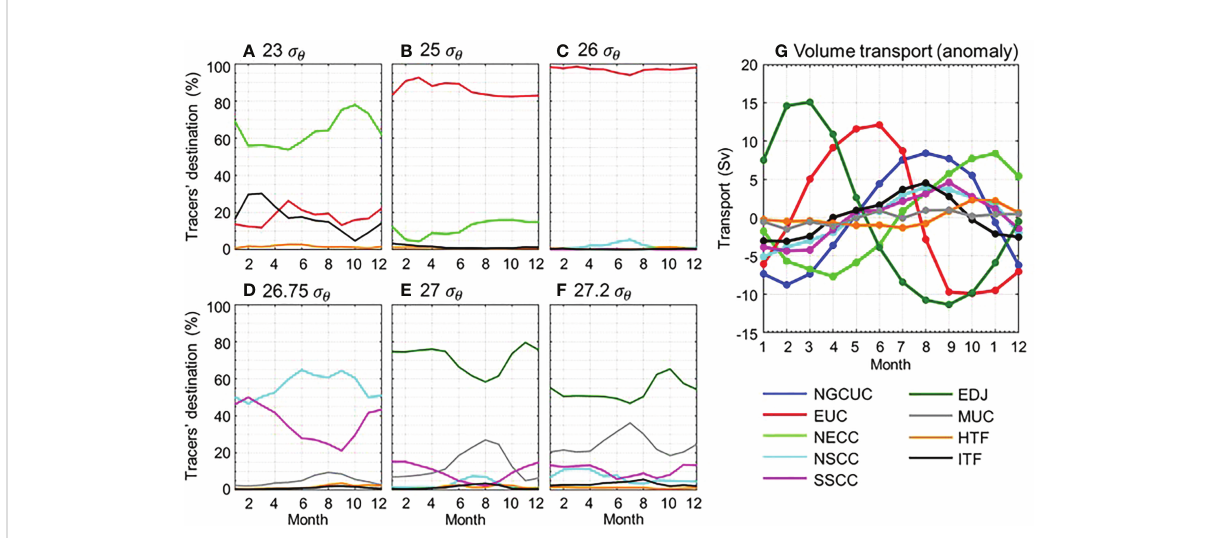
FIGURE 8 Monthly climatology (1994 – 2013) of the tracers ’ ratio that arrived at the prede fi ned sections of destination (%) at the density layers of (A) 23, (B) 25, (C) 26, (D) 26.75, (E) 27, (F) 27.2 s q . (G) Monthly climatology (1994 – 2015) of volume transport ’ s anomaly (Sverdrup) of NGCUC and its major